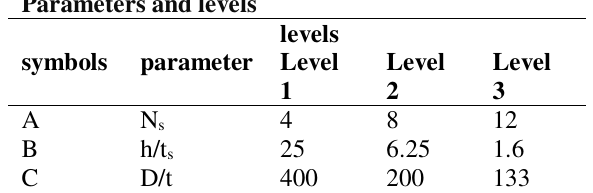
Fig. 3. Finite elements